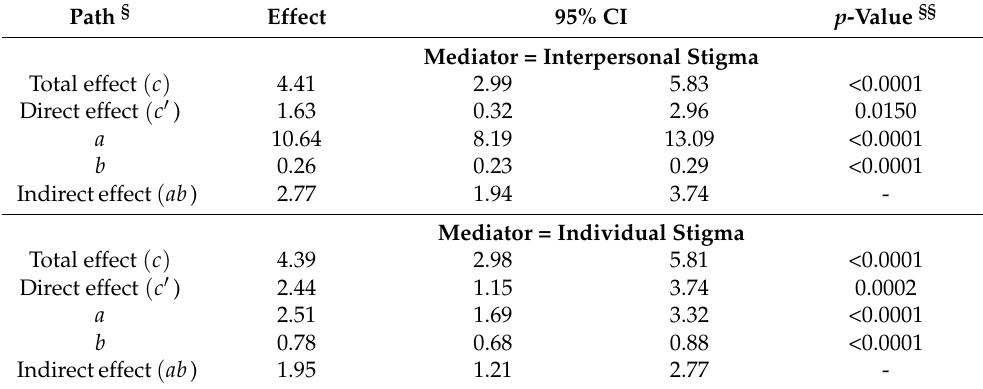
Table 2. The univariate mediation of interpersonal and individual stigma between the familiarity with transgender sports ban and suicidal